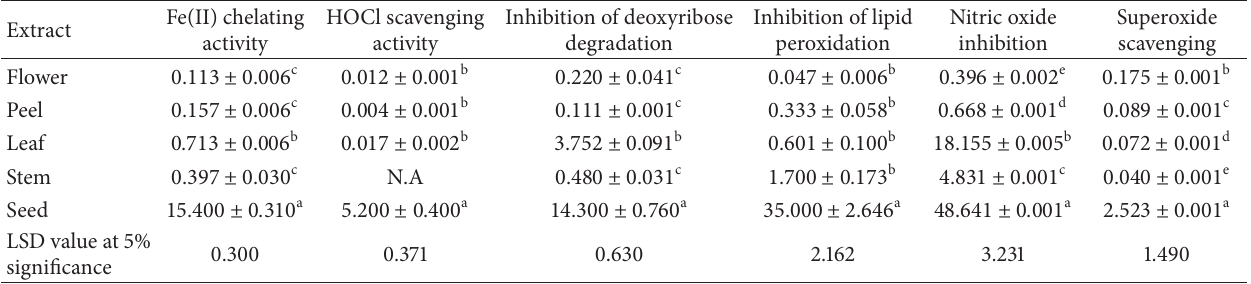
Table 2: Antioxidant activities of different pomegranate parts extract.